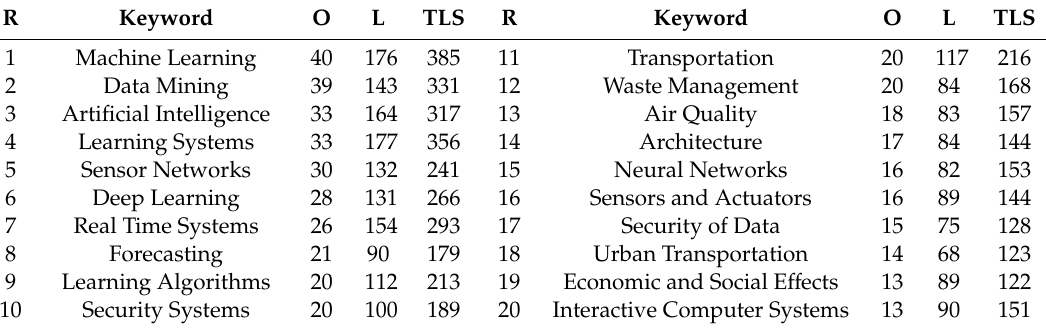
Table 6. Cluster 3: Top 20 keywords